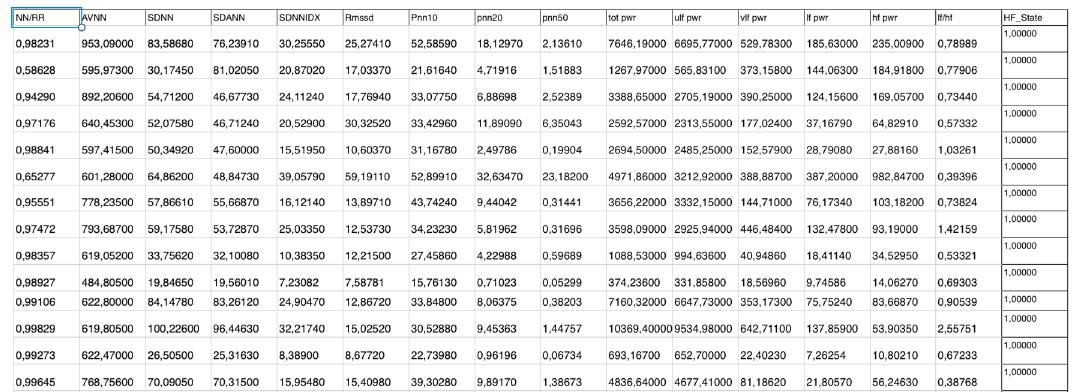
Figure 5. Abstract of current dataset in suitable format for analysis.